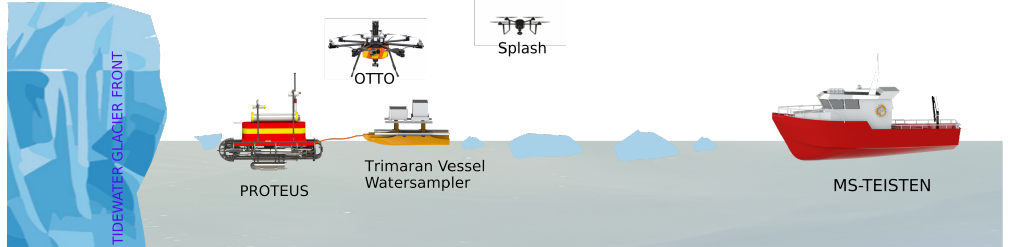
Figure 14. UVASS project: Fleet of heterogeneous UMVs